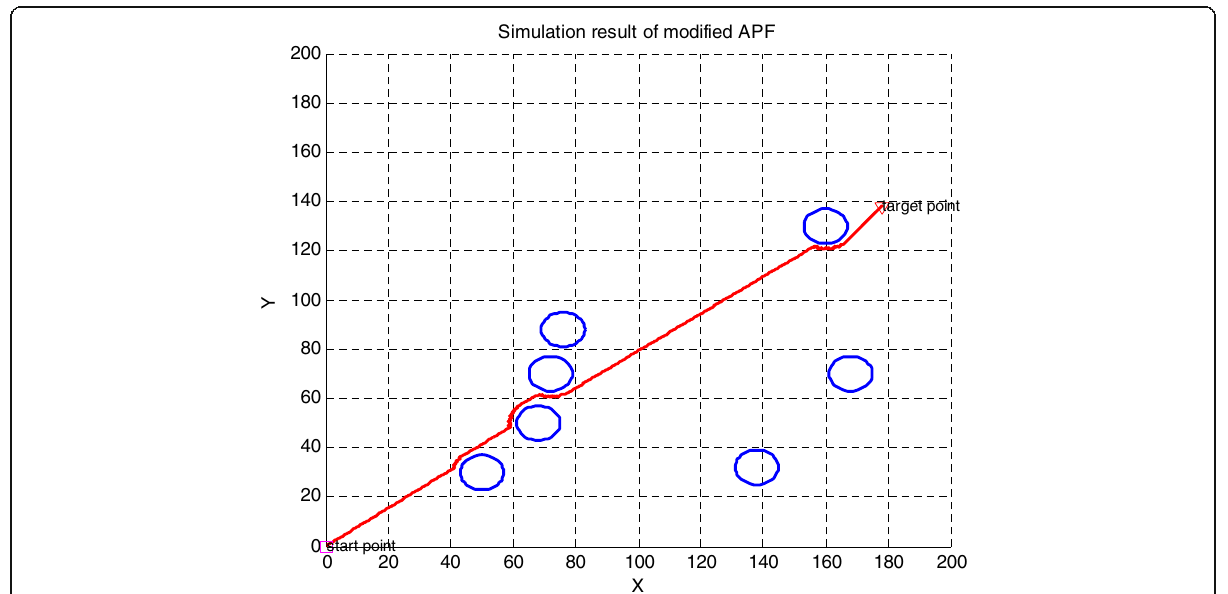
Fig. 17 The result of simulating circular obstacles with radius R = 7 in the modified artificial potential field algorithm